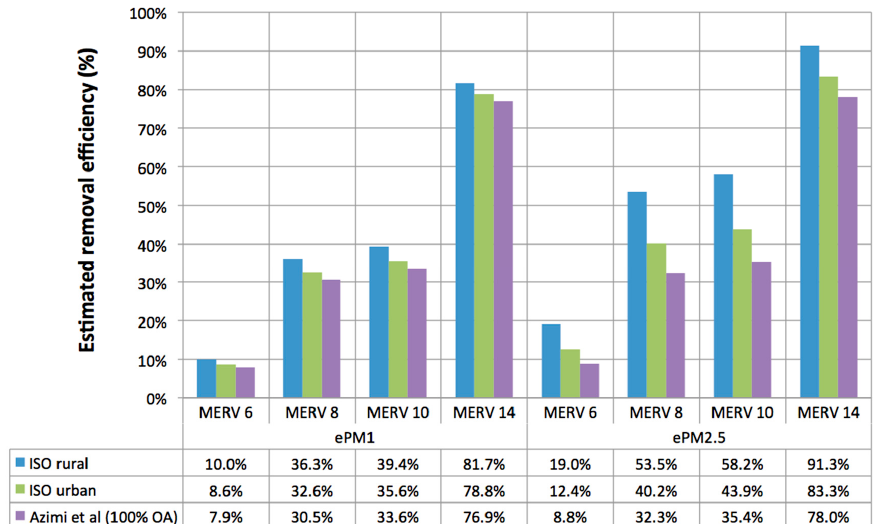
Figure 3. Estimates of e PM 1 and e PM 2.5 for four minimum efficiency reporting value (MERV)-rated filters from Hecker and Hofacre (2008) [35] made using the ambient urban and rural distributions from Jaenicke (1993) [31], and the average from using the 194 ambient distributions from Azimi et al. (2014) [29], assuming a filtration of 100% outdoor air.